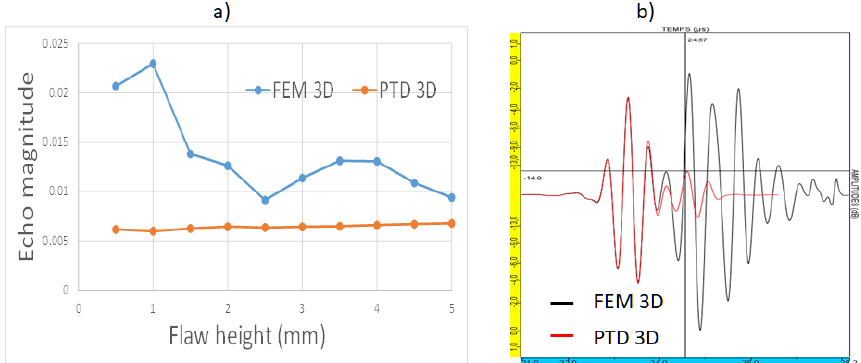
Figure 3. Inspection of a 25 mm extent rectangular crack inspected using P45 waves in TOFD mode at 2.25 MHz: ( a ) Echo magnitude versus the flaw height; ( b ) Ascans simulated both by the 3D FEM and PTD models for the 5 mm high crack.